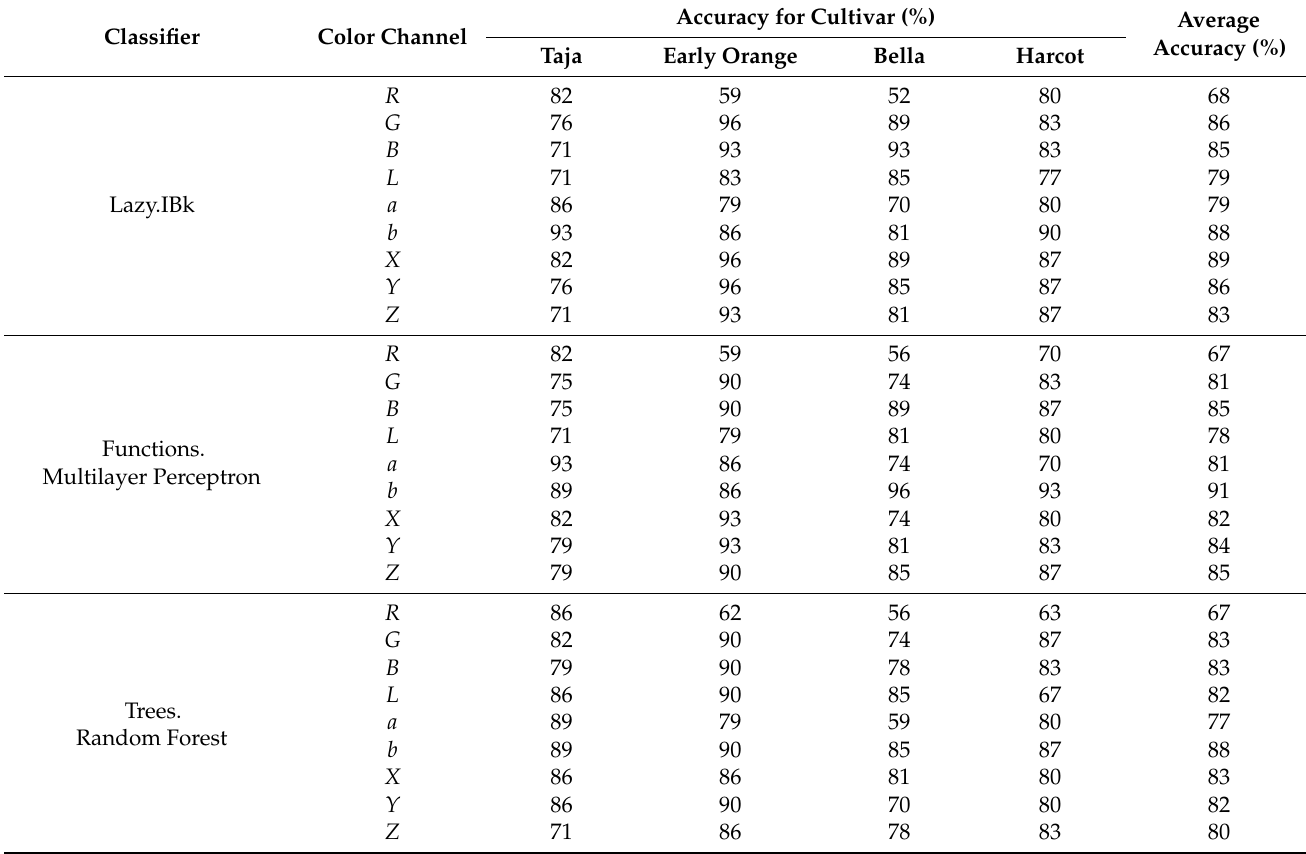
Table 1. The accuracies of cultivar classification of apricot seeds based on textures selected from individual color channels.